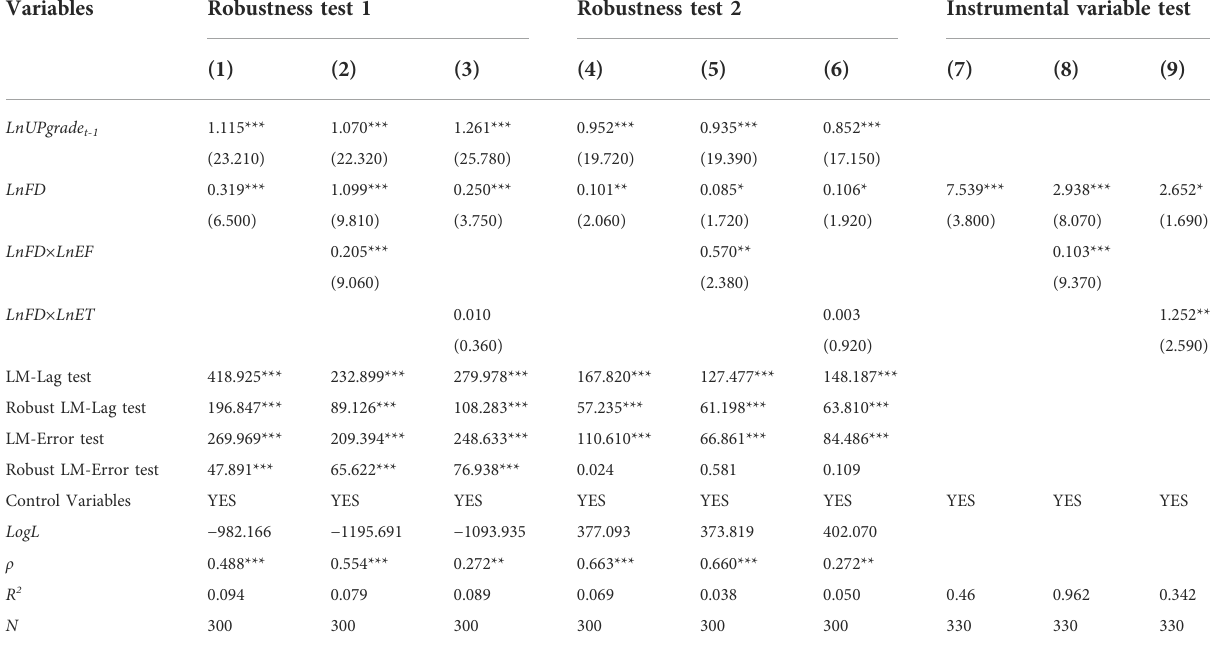
TABLE 9 The estimated results of robustness